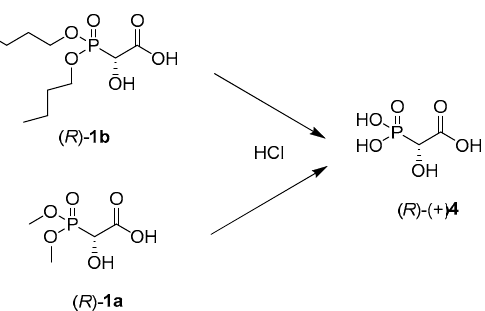
Figure 4. Anisotropic effect of P=O group on hydrogen atoms of methoxy groups. Comparison of all spectra allowed for assignment of the absolute configuration of enantiomers of compounds 1b and 2b (Figure